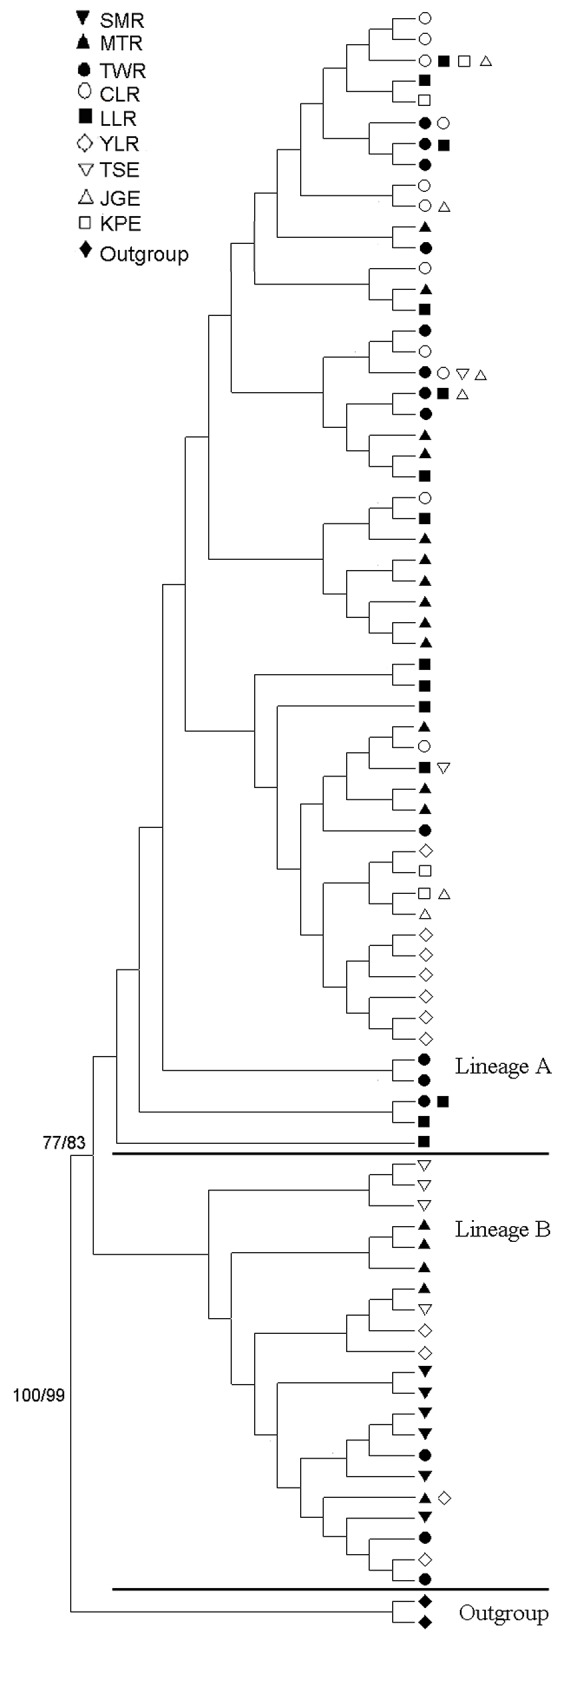
Neighbor-joining (NJ) tree based on mtDNA 16S + COI sequences with bootstrap values (NJ/ML, respectively) shown adjacent to corresponding two lineages for Macrobrachium nipponense.Number at the nodes indicate bootstrap values (expressed as percentage) with 1,000 replicates.